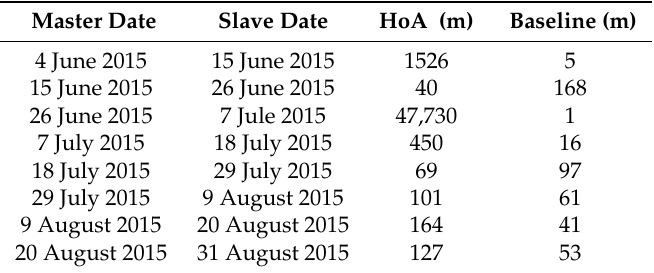
Table 3. List of repeat-pass